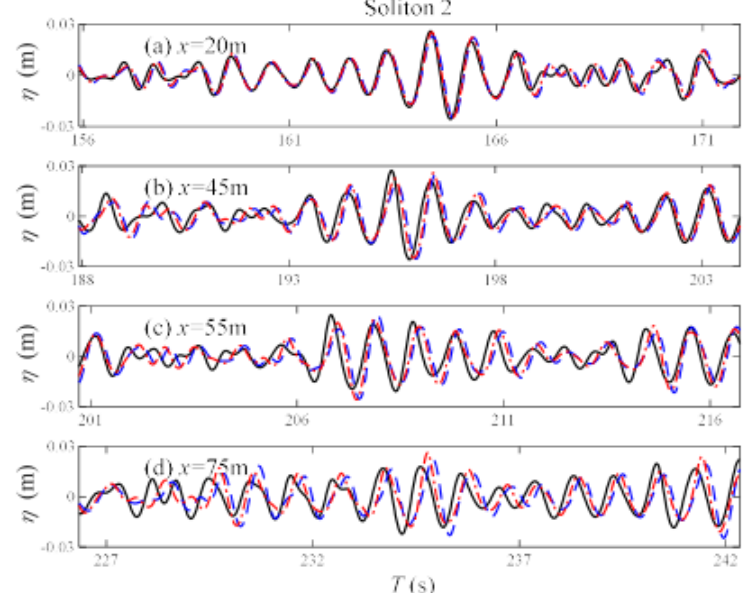
Figure 8. Comparison of Soliton 2 between different nonlinear orders. The blue dashed lines correspond to the simulation with only linear effects ( M = 1). The red dashed dot lines correspond to the simulation with second harmonic effects ( M = 2). The black solid lines correspond to almost fully nonlinear simulations ( M =